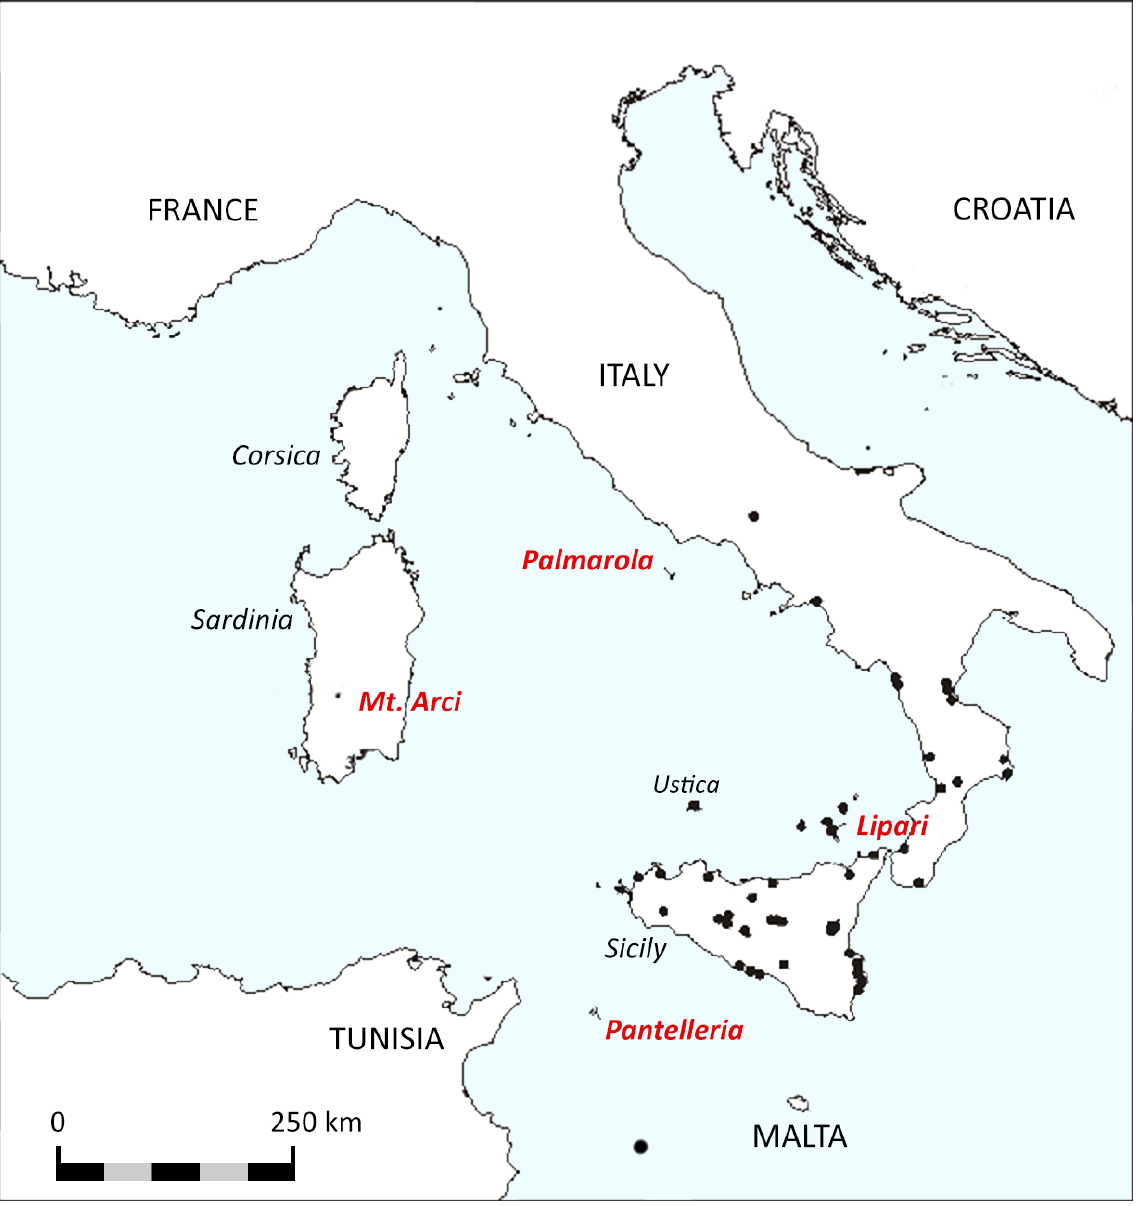
Figure 1: Map of the area being investigated. The four main sources of obsidian in Italy are marked. The sites indicated are those listed in Table 1. Most sites yielded almost exclusively Lipari obsidian, with the exceptions a few coastal sites facing Pantelleria in the western part of